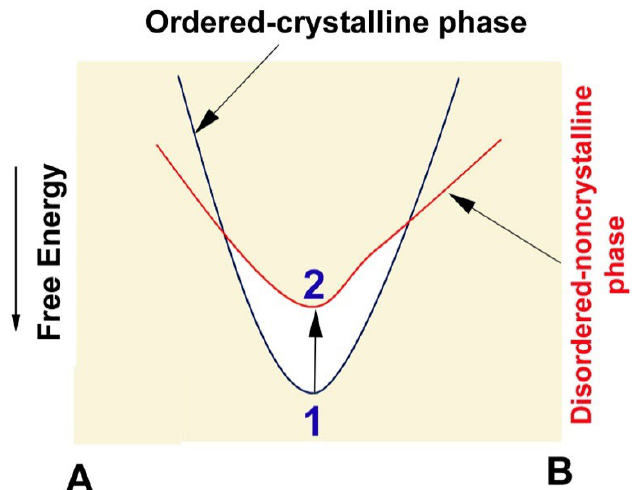
Figure 6. Schematic free-energy diagram for the phases involved in the MD process, starting from (1) an intermetallic phase of AB (Point 1) to reach a lower stability level (Point 2).